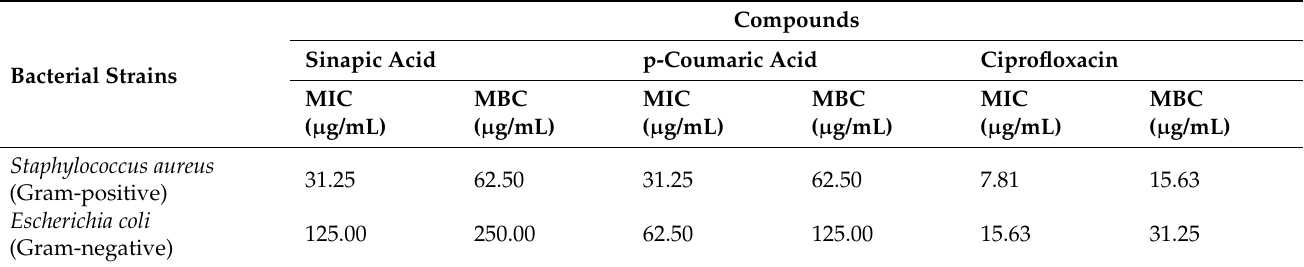
Table 4. Minimum inhibitory concentration (MIC) and minimum bactericidal concentration (MBC) of the tested compounds against bacterial cultures.